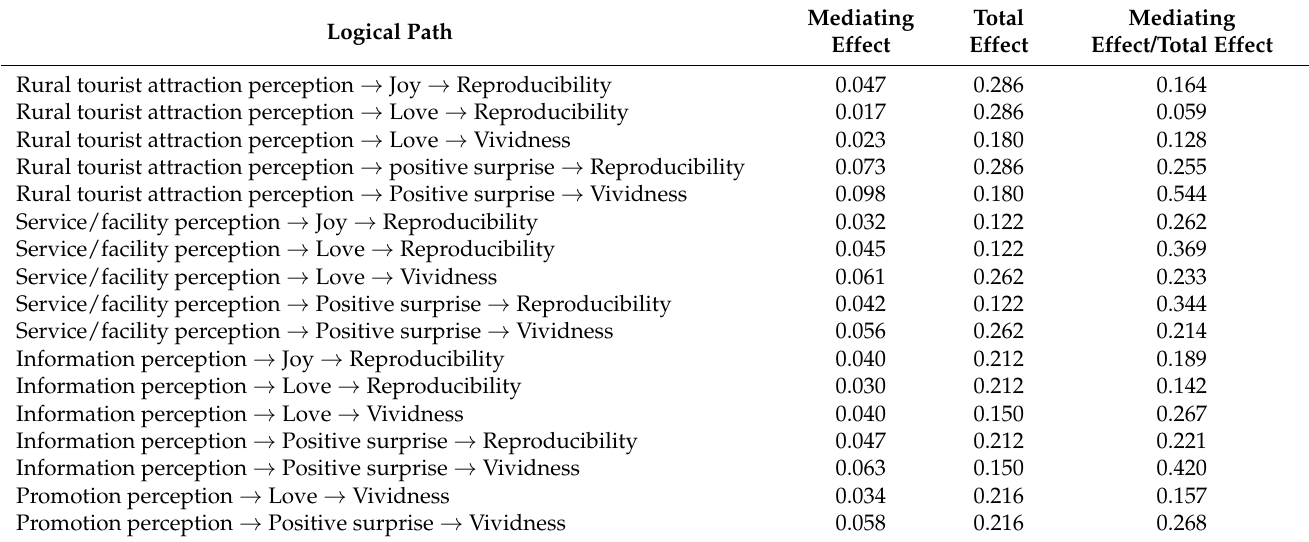
Table 6. Mediating effect analysis of research